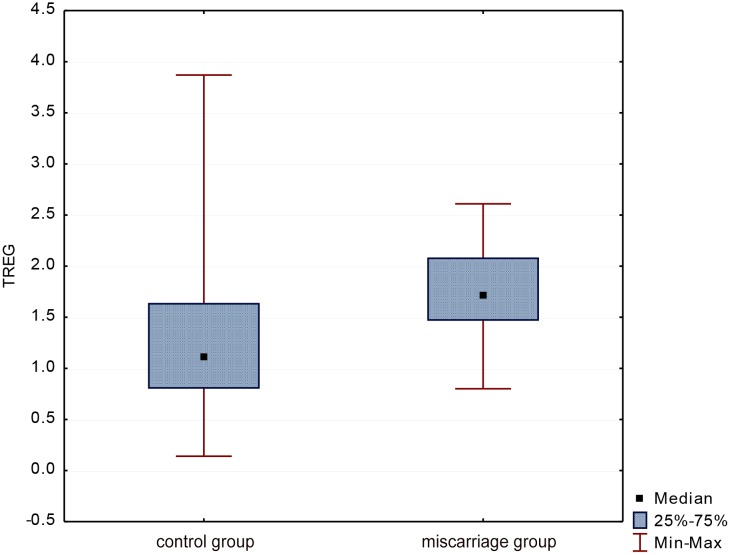
Evaluation of TREGs percentage in groups.